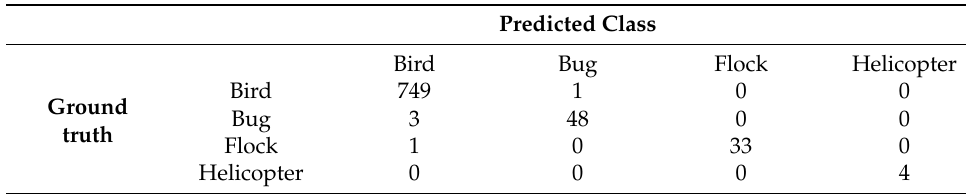
Table 4. The confusion matrix for multi-class classification.